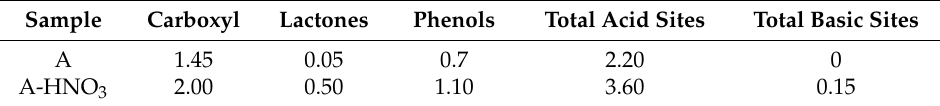
Table 2. Quantification of the chemical surface groups (meq · g − 1 ) by Boehm titration.